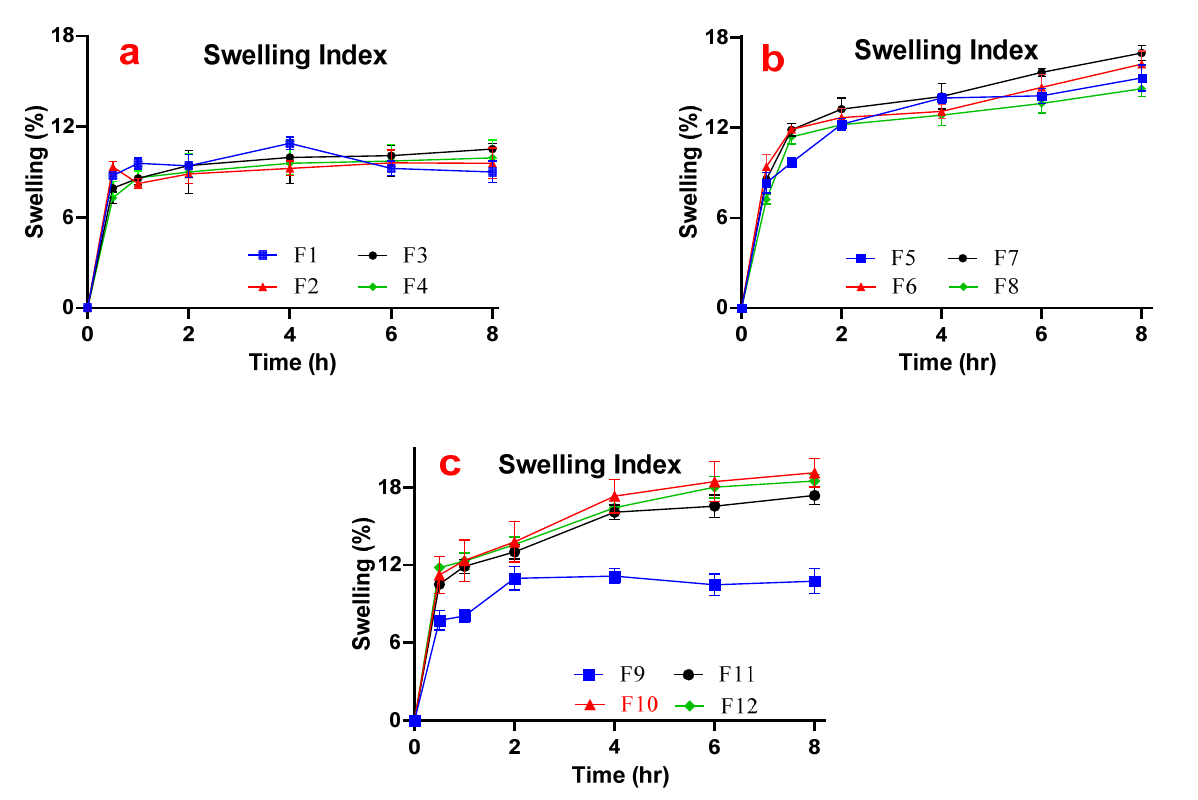
Figure 8. Swelling trend of formulations containing ( a ) AG alone (F1–F4), ( b ) Carbopol alone (F5–F8), and ( c ) AG-CP composite